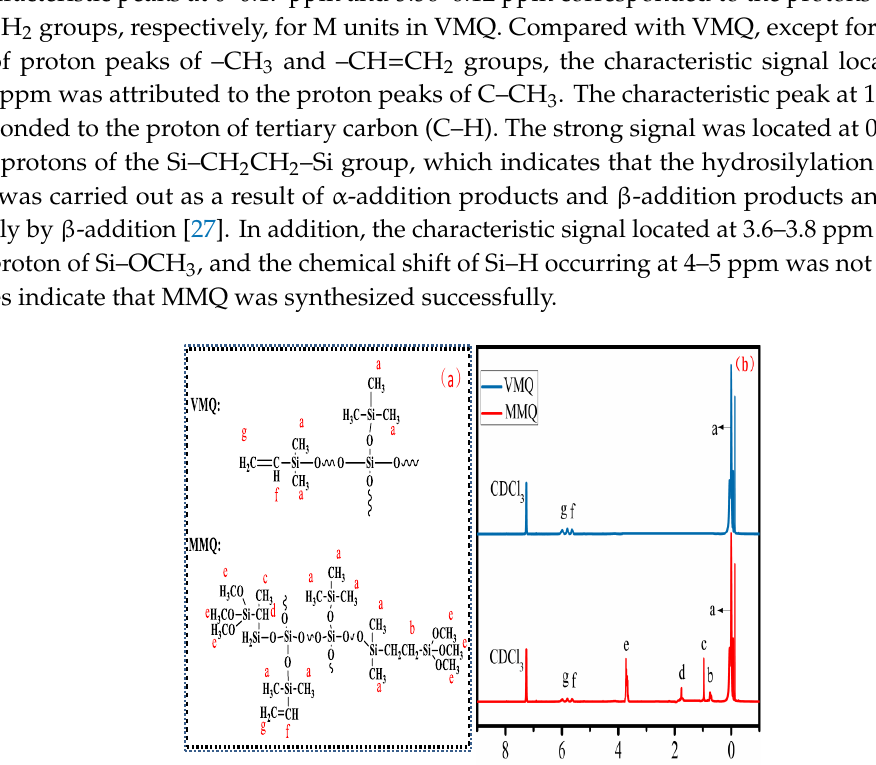
Figure 3. 1H NMR spectroscopic analysis. ( a ) Molecular formulas of VMQ and MMQ, ( b ) 1H NMR spectra of VMQ and MMQ.